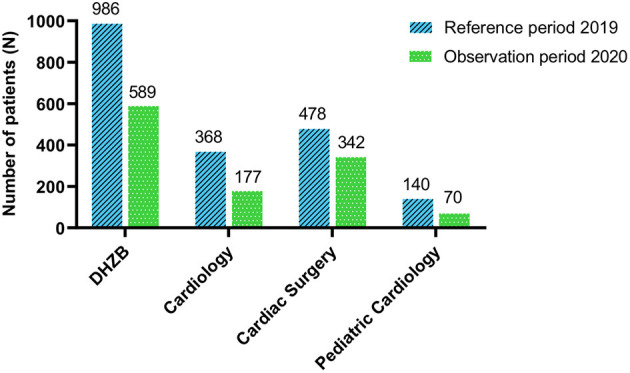
Number of inpatients treated during the COVID-19 pandemic in comparison to the reference period in 2019. Total reduction of patients admitted during the reported period compared to the same time period in 2019 in different departments of the German Heart Center Berlin. DHZB, Deutsches Herzzentrum Berlin (German Heart Center Berlin).